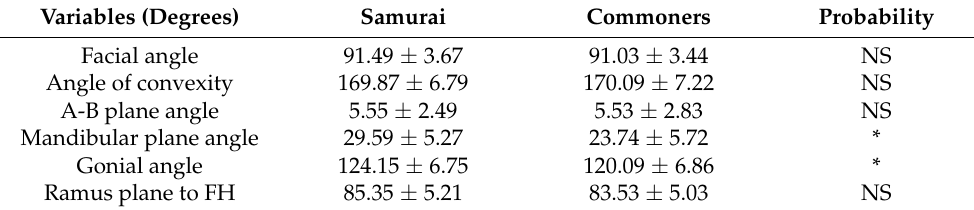
Figure 2. Representative 3D images: ( A ) samurai; ( B ) commoner. Table 2. Comparison of skeletal variables between samurai and commoners.